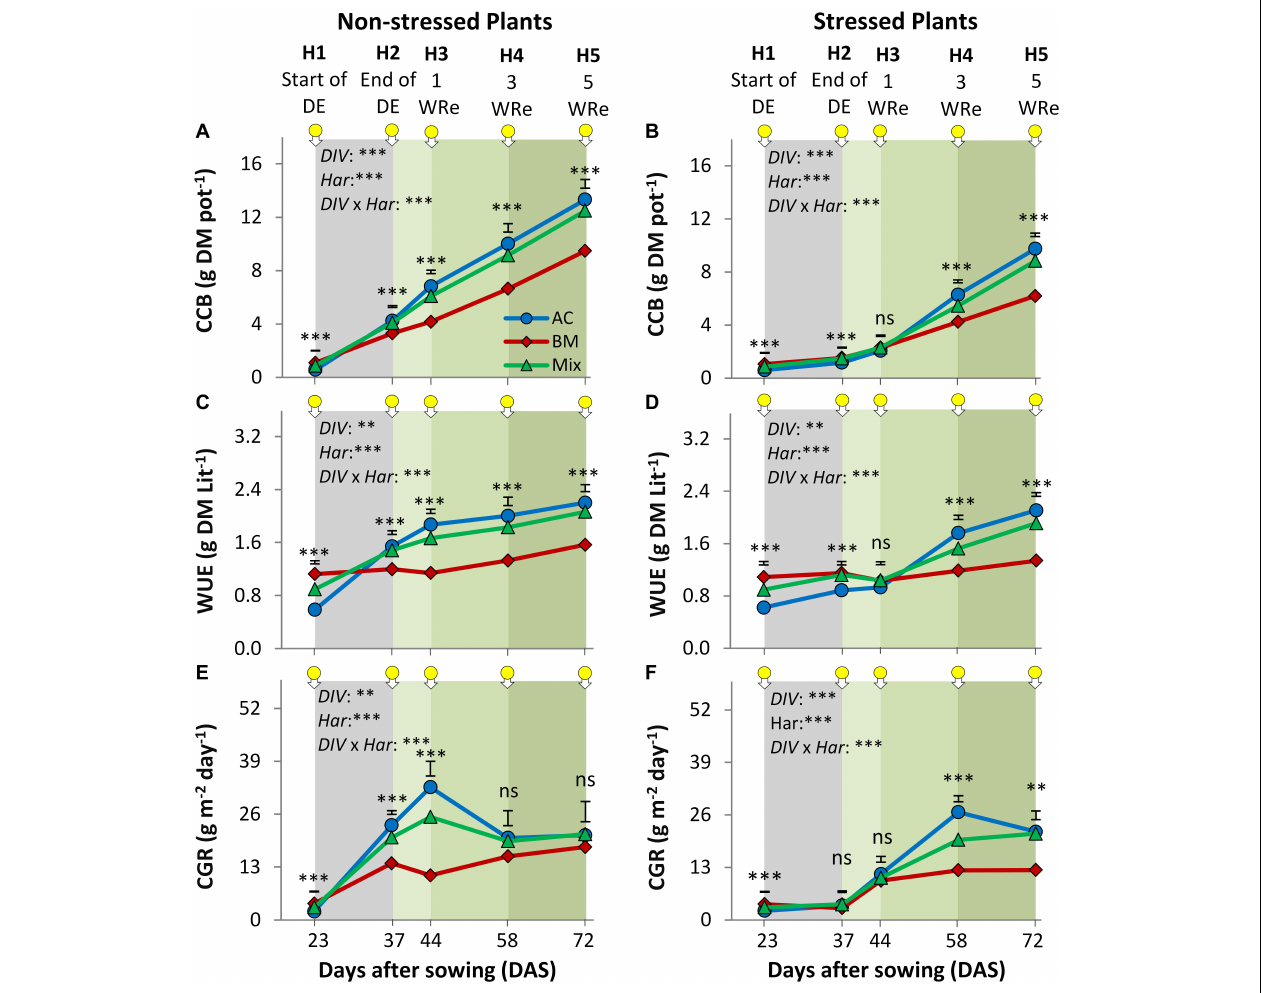
FIGURE 3 | Cover crop aboveground biomass (CCB; A,B ), water use efficiency (WUE; C,D ), and crop growth rate (CGR; E,F ) of alsike clover (AC), black medic (BM) in monocultures and a 1:1 mixture of the two species (Mix). The non-stressed plants (A,C,E) and stressed plants (B,D,F) were harvested five times indicated by the downward arrows tagged with yellow small circles. The stressed plants were subjected to a drought event (DE; gray shaded) for 14 days. The green gradient color represents weeks of recovery (WRe) after rewatering. Vertical bars represent Tukey’s HSD test ( P < 0.05) at a given harvest time ( n = 5). Asterisks above the vertical bars indicate significant differences among the mean of the monocultures and mixture at each harvest time based on one-way ANOVA at P < 0.05. However, asterisks next to the factors DIV , Har , and DIV × Har indicate significant effects based on ANOVA results of the generalized linear model; ∗∗∗ P < 0.001, ∗∗ P < 0.01, ns, not